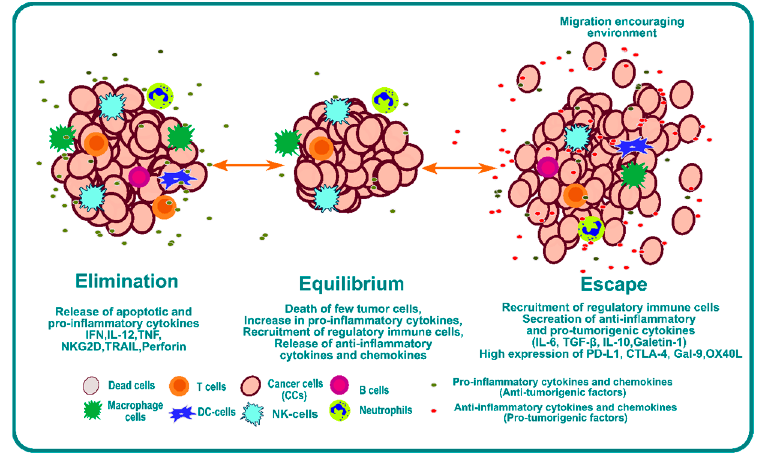
Figure 1. Schematic representation of the phases of immunoediting, namely elimination, equilibrium, and escape.